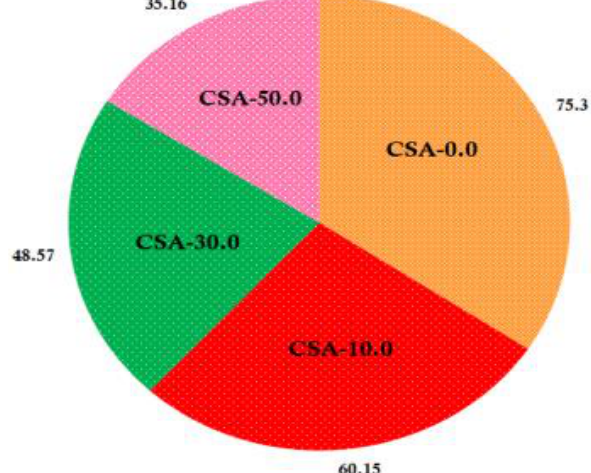
Figure 8. Water solubility versus film type.